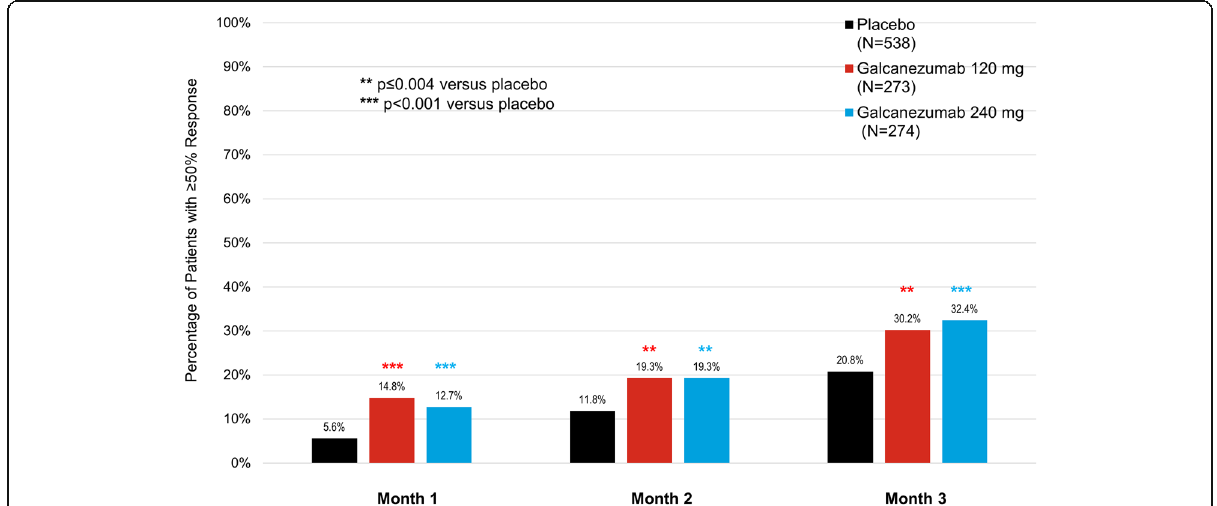
Fig. 4 Cumulative maintained ≥ 50% response: percentages of patients with chronic migraine who reached ≥ 50% response at or before each month and all subsequent